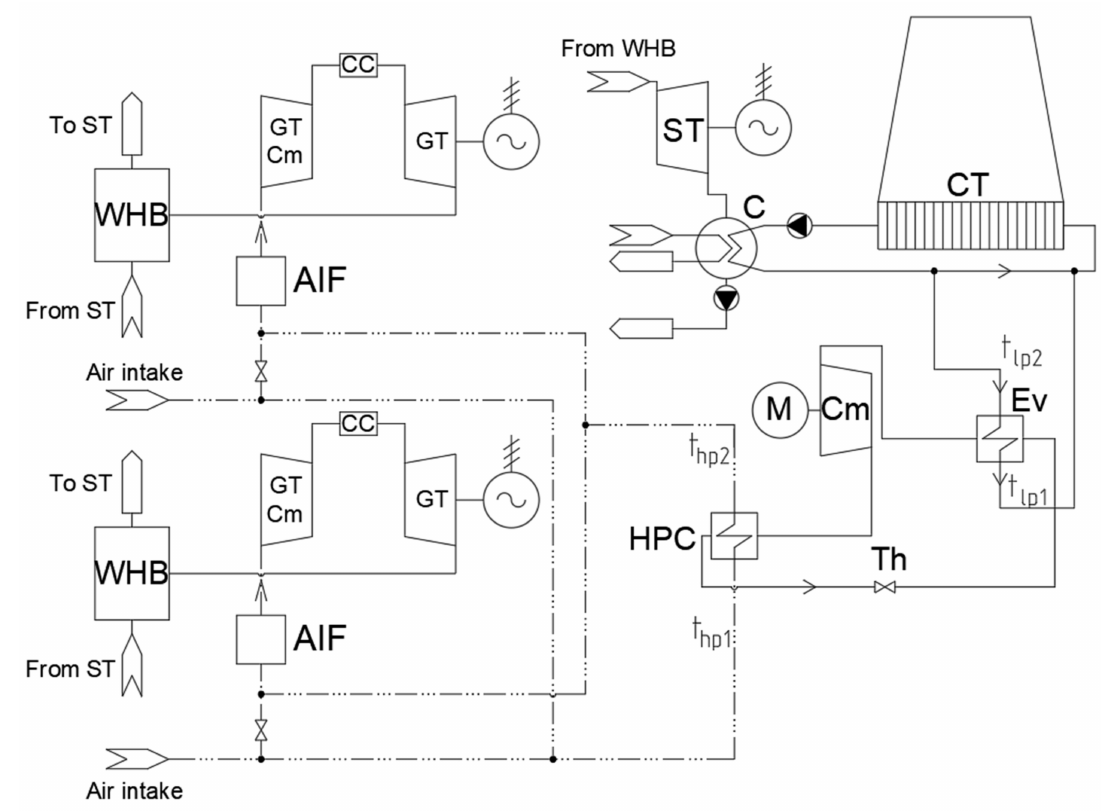
Figure 8. The scheme of air heating before AIF’s intake in winter time using a simple scheme VCHP.